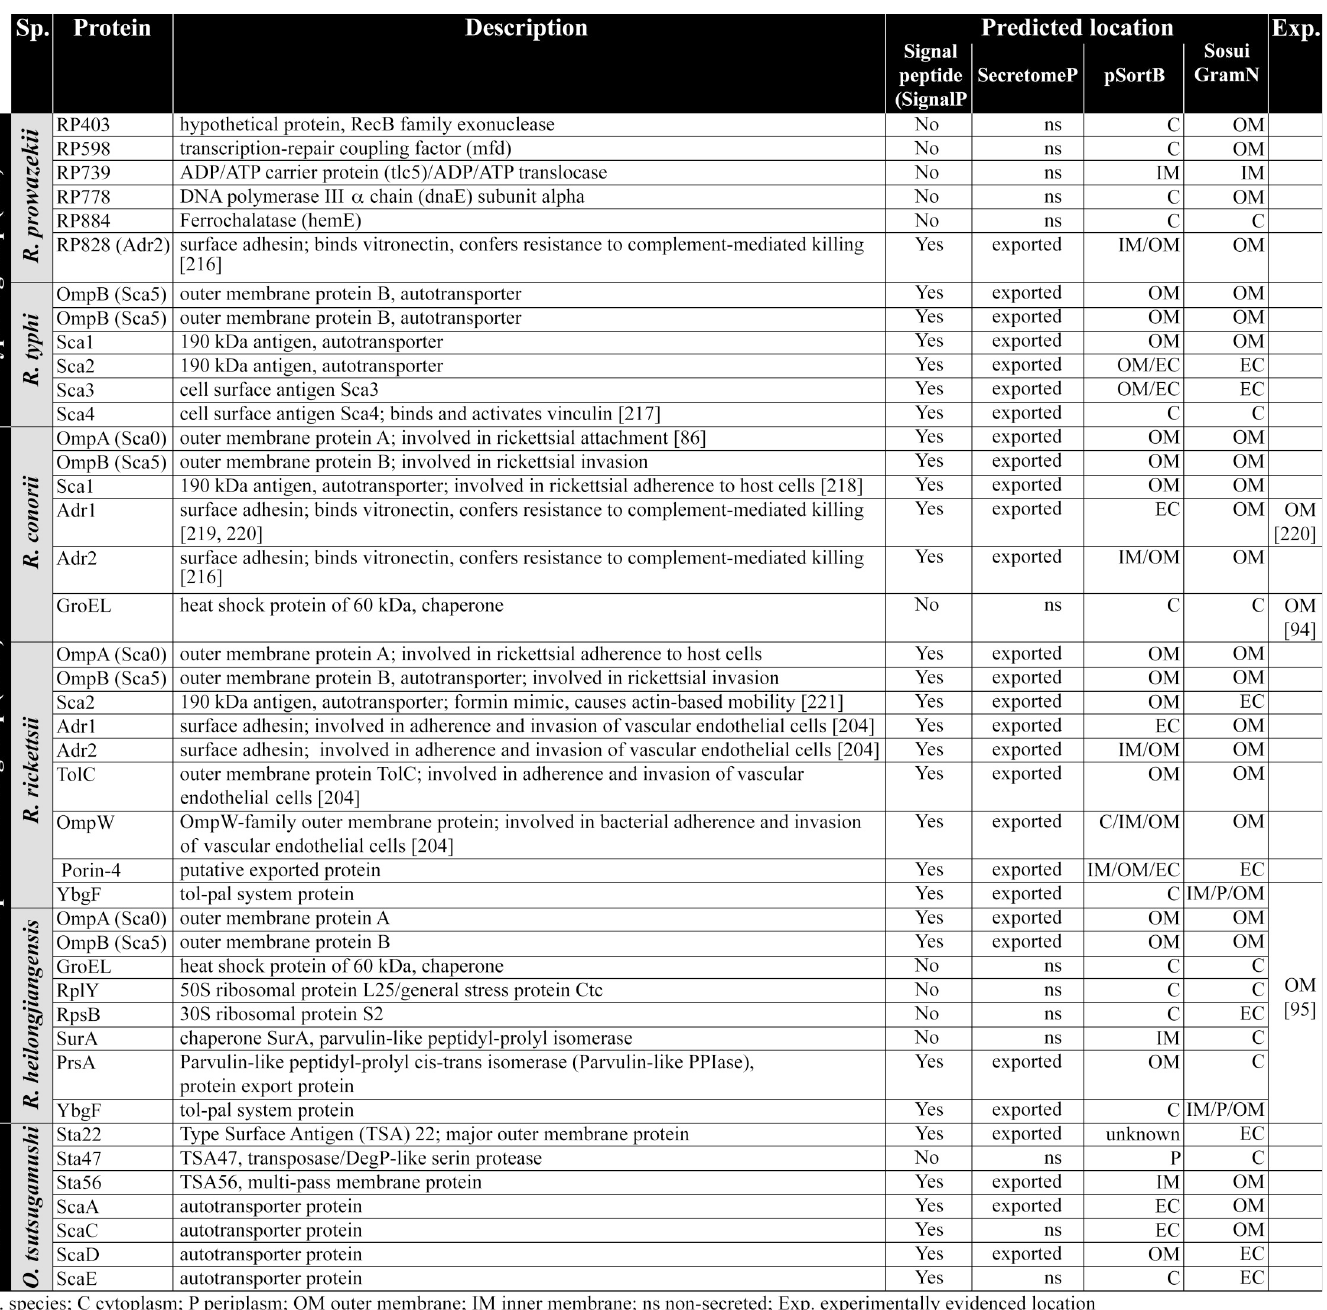
Fig 6. Description of protein function and predicted and/or experimentally evidenced subcellular location. The predicted function and predicted and/or experimentally evidenced location of the immunogenic rickettsial antigens is depicted [86,94,95,204,216–221]. C, cytoplasm; Exp., experimentally evidenced location; IM, inner membrane; ns, non-secreted; OM, outer membrane; P, periplasm; SFG, spotted fever group; Sp., species; TG, typhus group; TSA, Type Surface